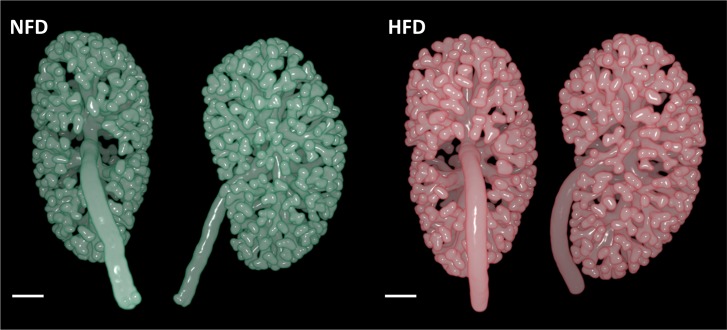
Representative OPT images of E15.5 kidneys from offspring of NFD and HFD dams.Ureteric epithelium rendered using Drishti software. Scale bar = 200 μm.